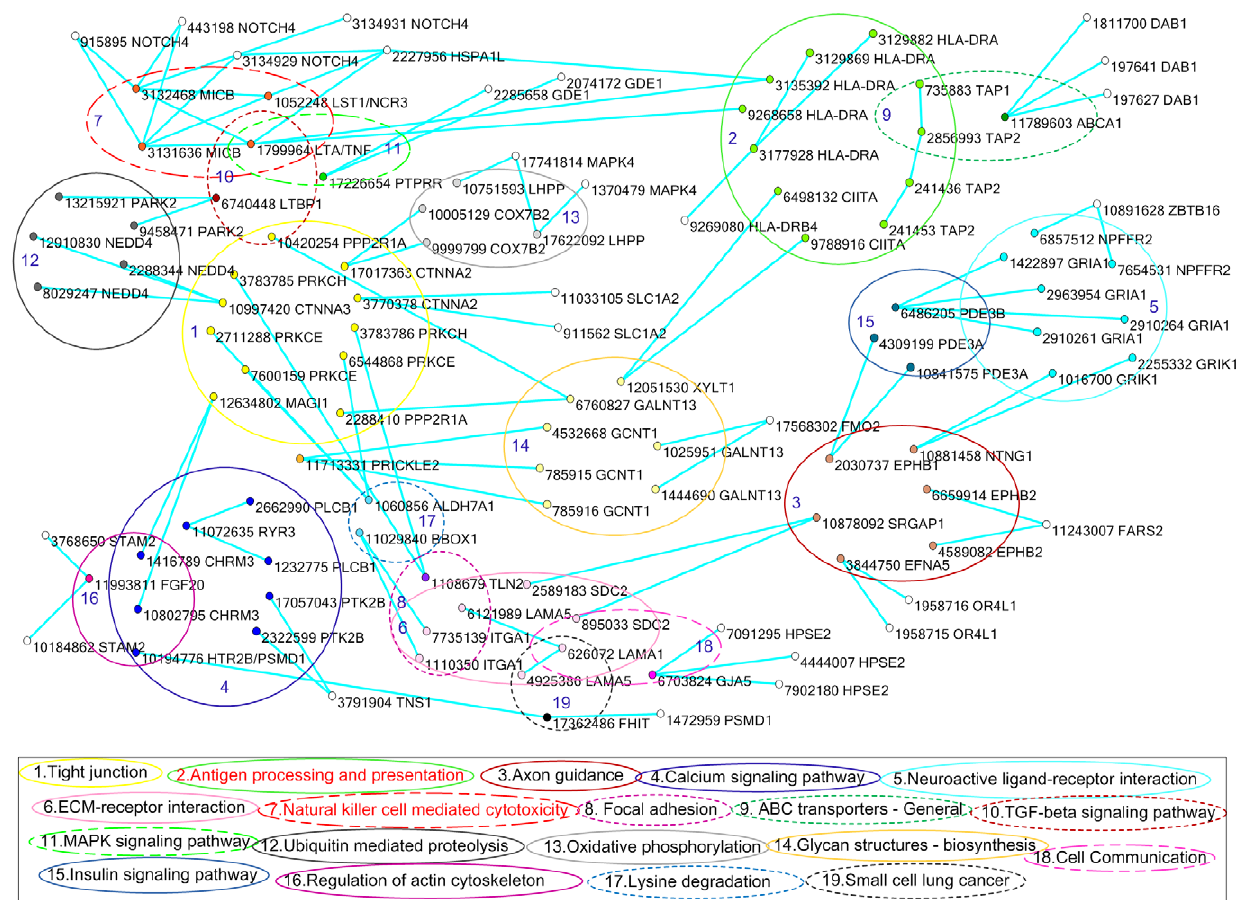
Figure 6. Interacting SNPs that were located in 19 pathways formed a network. Each pathway was represented by an ellipse with the number. The SNPs were represented by nodes and placed insight their located pathways. Nearby each SNP there was its RS number and the name of its located gene. The pathway and its harbored SNPs were labeled by the same color. The interacting SNPs were connected by the solid light green lines.